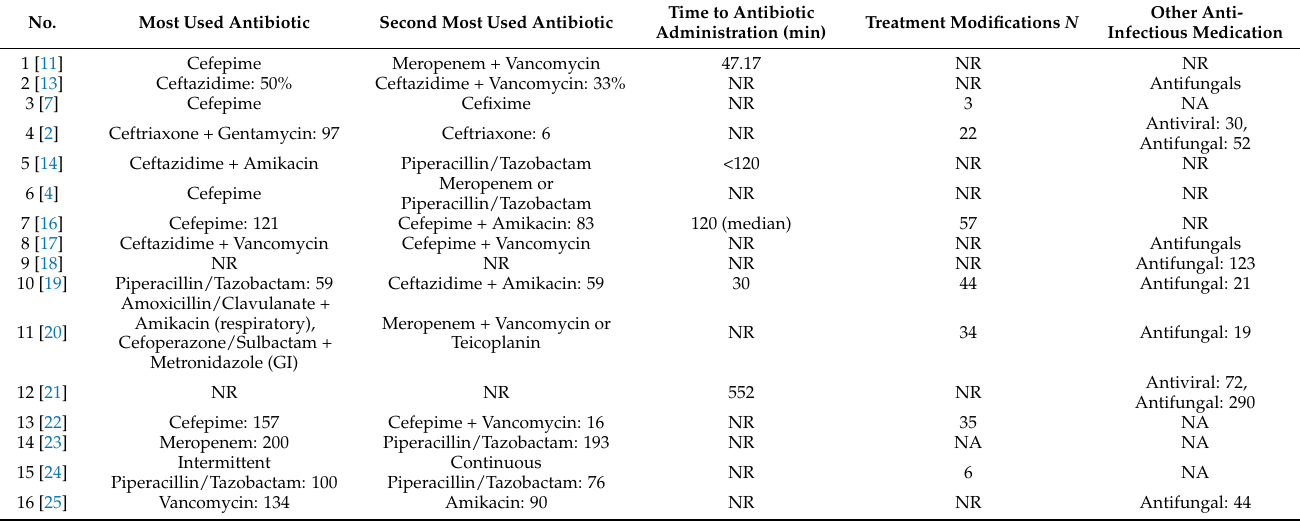
Table 4. Treatment data extracted from the studies.